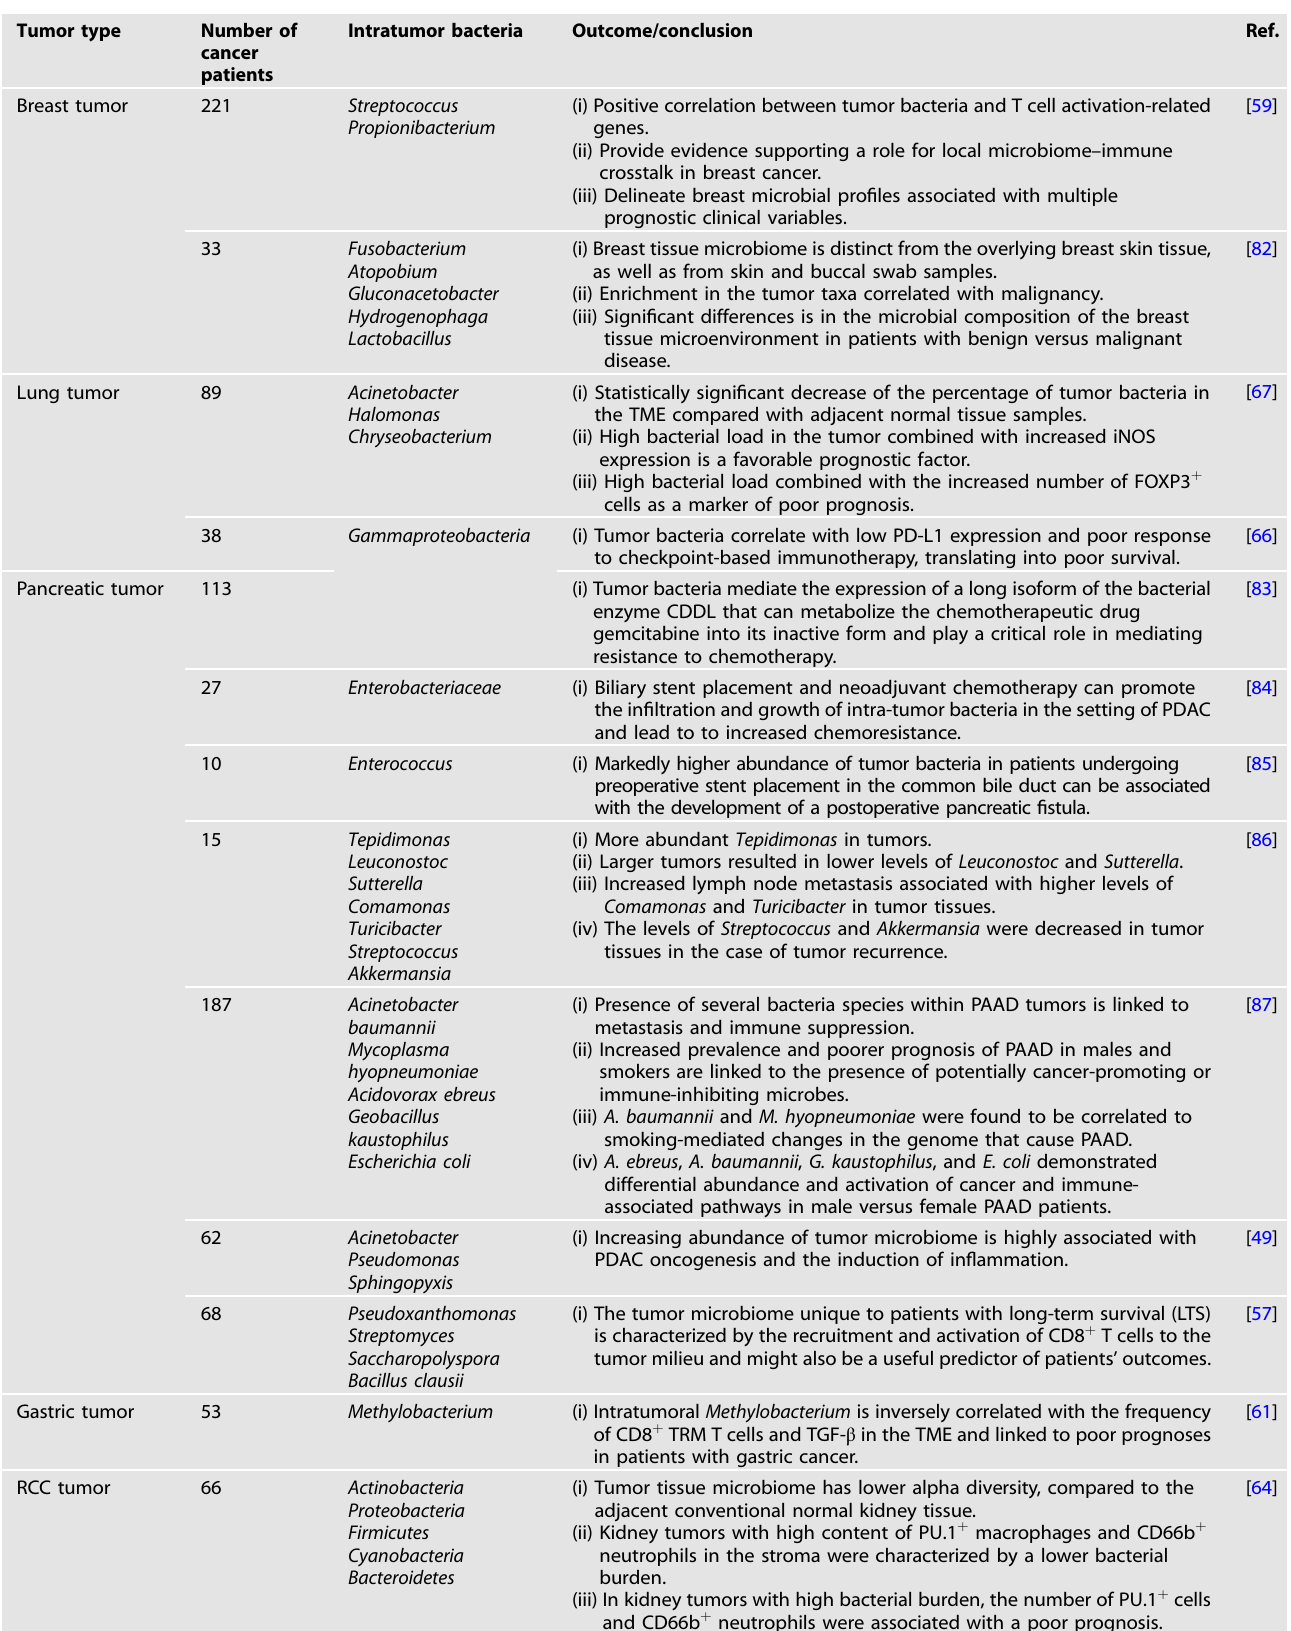
Table 1. Association of intratumoral bacteria with human tumor. Tumor